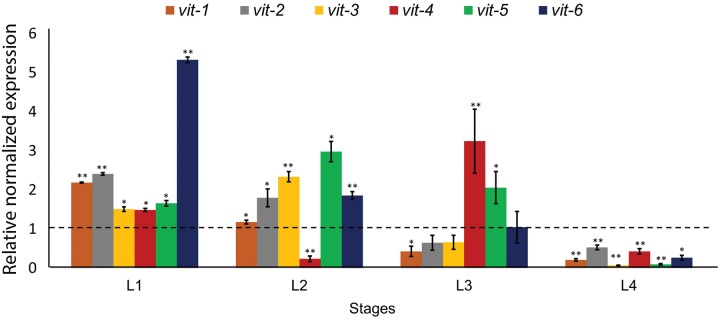
Expression of vit genes in pry-1(mu38).(A) qRT-PCR of vit genes at larval stages in pry-1(mu38) mutants. Relative normalized expression has been plotted. Data represents the mean of at least two replicates and error bar represents the SEM. *p<0.05 and **p<0.01, compared to wild-type which is normalized to 1.